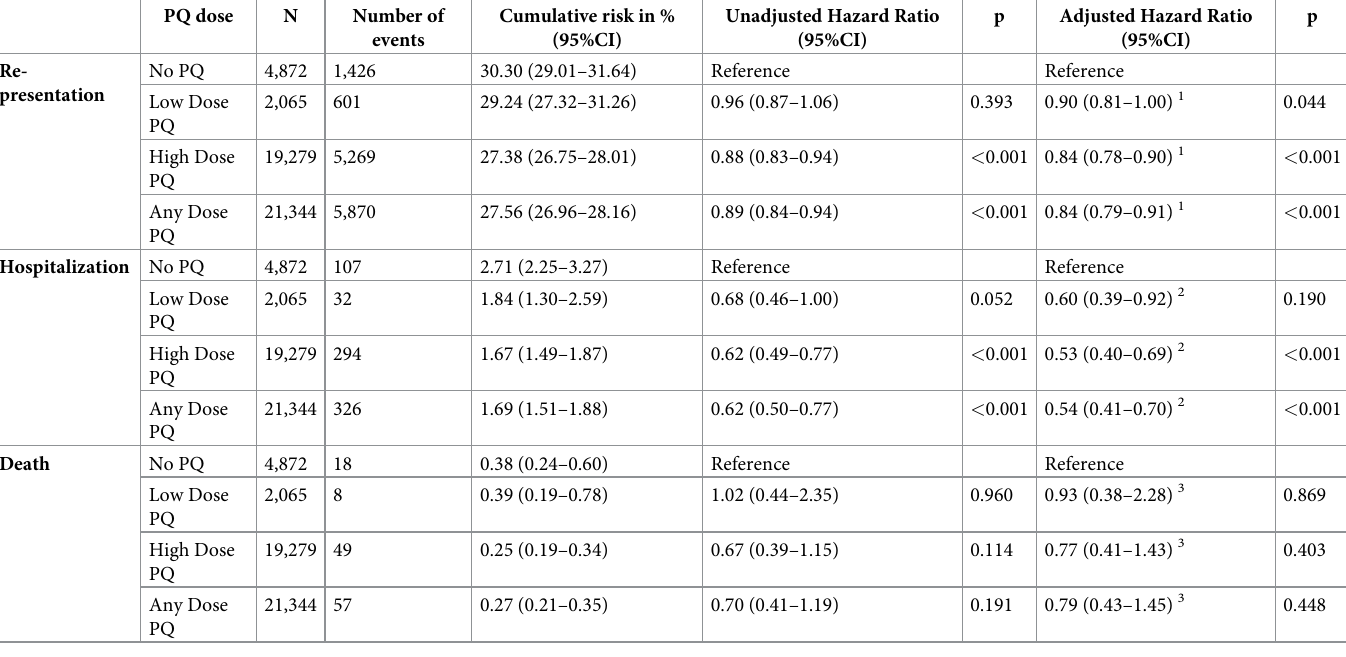
Table 2. Risk of all cause re-presentation, hospitalization and death within 30 days after different doses of primaquine. PQ